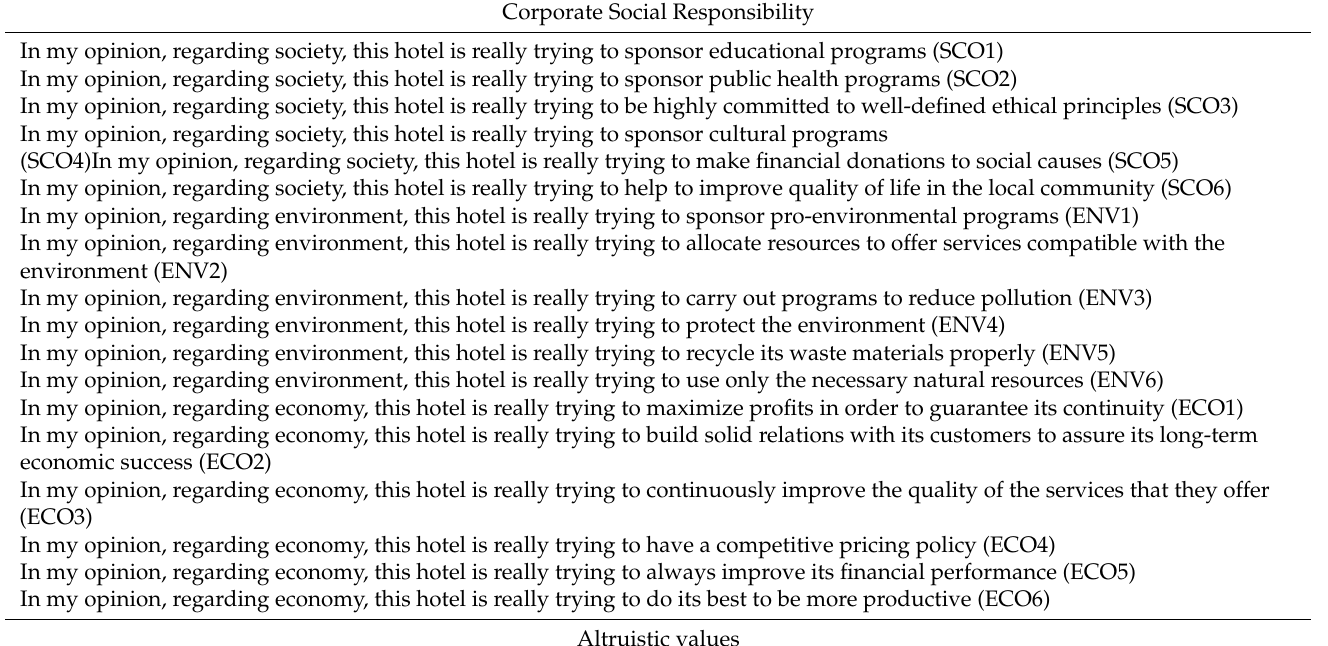
Table A1. Items Used in This